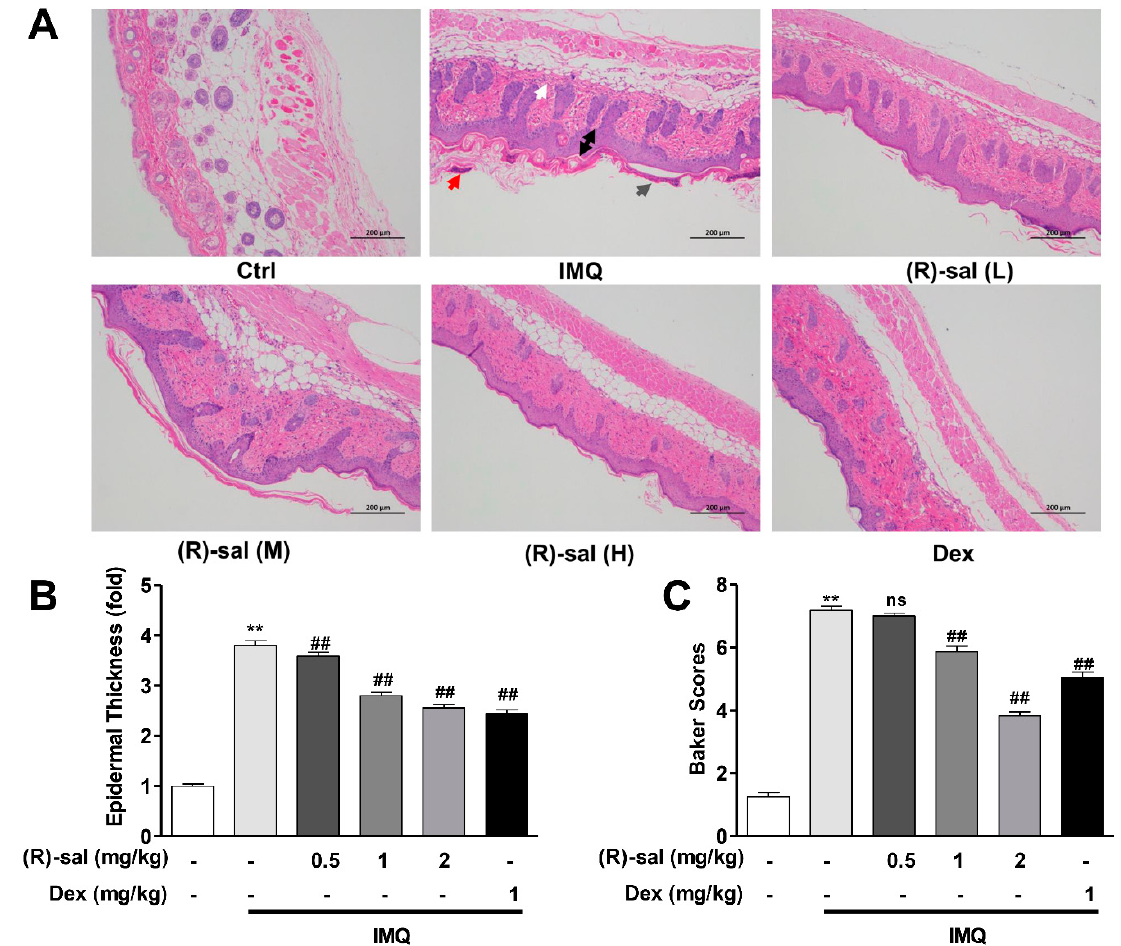
Figure 3. Treatment with ( R )-salbutamol ameliorated the morphological changes induced by IMQ. ( A ) ( R )-salbutamol improves pathological injury. (Scale bar: 200 µm) White arrows show inflammatory cell infiltration, gray arrows show parakeratosis, red arrows represent Munro’s microabscesses, and black arrows was thickened prickle cell layer of the epidermis. ( B ) ( R )-salbutamol alleviates epidermal thickness of the dorsal skin on day 8. ( C ) ( R )-salbutamol decreased Baker score. # p < 0.05, ## p < 0.01, compared with IMQ group. ** p < 0.01, compared with control group. Each bar represents the mean ± SD ( n = 8).